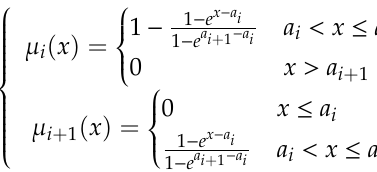
Figure 2. Parabolic-type function.